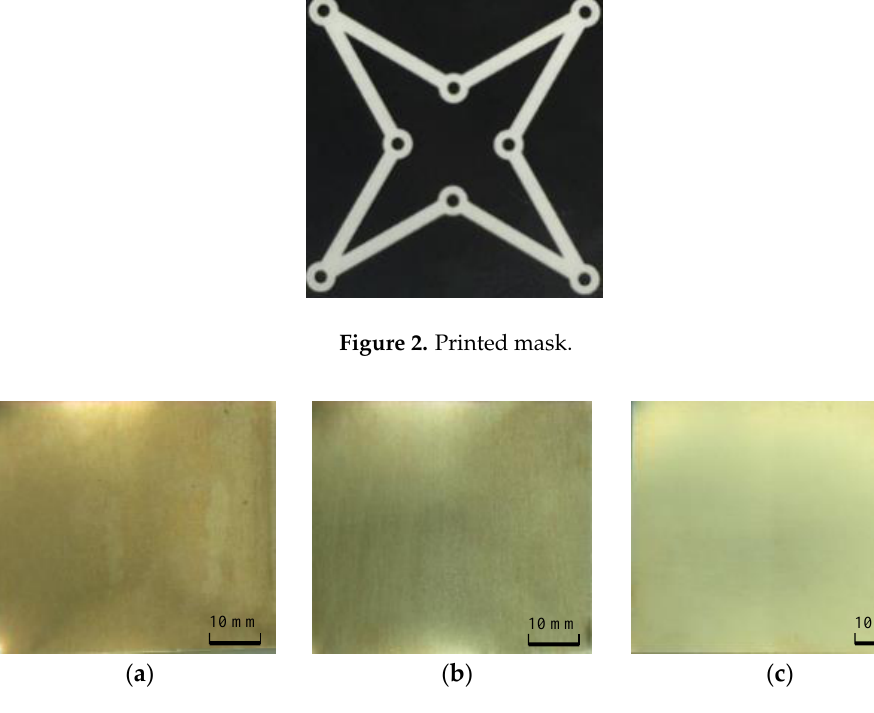
Figure 3. Images of beryllium bronze sheet: ( a ) original, ( b ) polished, ( c ) and cleaned. (4) Pasting photo-sensory membrane.